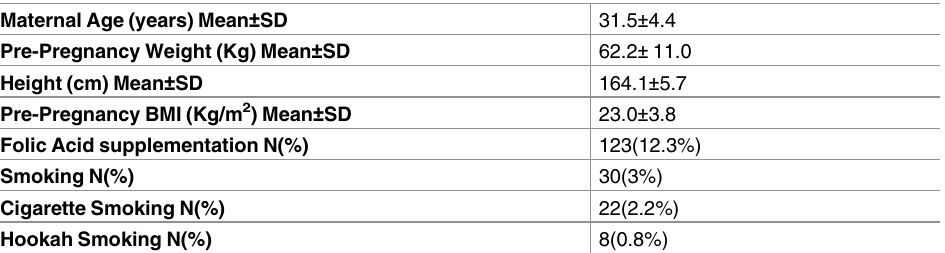
Table 2. General characteristics of the mothers (N =